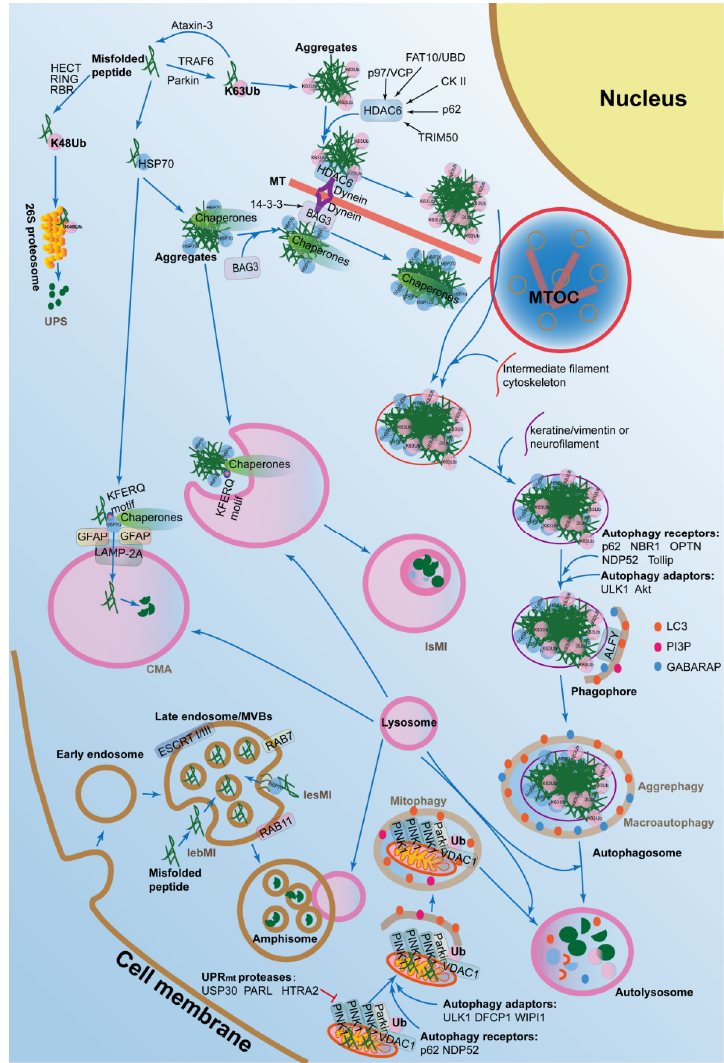
Figure 2. The autophagy-lysosomal pathways (ALPs) in the regulation of proteostasis. The ALPs are composed of macroautophagy, chaperone-mediated autophagy, aggrephagy, mitophagy, and microphagy. Abbrreviations: IsMI, lysosomal microautophagy; lesMI, late endosomal selective microautophagy; lebMI, late endosomal bulk microautophagy; CMA, chaperone-mediated autophagy; MT, microtubule; MTOC, microtubule organizing center; HECT, homologous to the E6-AP carboxyl terminus; RING, really interesting new gene; RBR, RING-betweenRING-RING; TRAF6, TNF receptor associated factor 6; p97/VCP, valosin containing protein; FAT10/UBD, ubiquitin D; CK II, casein kinase II; p62/SQSTM1, sequestosome 1; TRIM50, tripartite motif containing 50; HDAC6, histone deacetylase 6; BAG3, Bcl2-associated athanogene 3; GFAP, glial fibrillary acidic protein; LAMP-2A, lysosomal associated membrane protein 2; NBR1, neighbor of BRCA1 gene 1; OPTN, optineurin;NDP52, nuclear domain 10 protein 52; ULK1, Unc-51 like autophagy activating kinase 1; DFCP1, double FYVE-containing protein 1; WIPI1, WD repeat domain, phosphoinositide interacting 1; LC3, microtubule associated protein 1 light chain 3 alpha; PI3P, phosphatidylinositol 3-phosphate; GABARAP, gamma-aminobutyric acid receptor-associated protein; PINK1, PTEN induced putative kinase 1; Parkin, parkin RBR E3 ubiquitin protein ligase; MVBs, multivesicular bodies; ALFY, autophagy-linked FYVE-domain containing protein; VDAC1, voltage dependent anion channel 1; RAB7, Ras-related protein 7; RAB11, Ras-related protein 11; ESCRT I/III, endosomal sorting complex required for transport I/III; USP30, ubiquitin specific peptidase 30; PARL, presenilin associated rhomboid like; HTRA2, HtrA serine peptidase